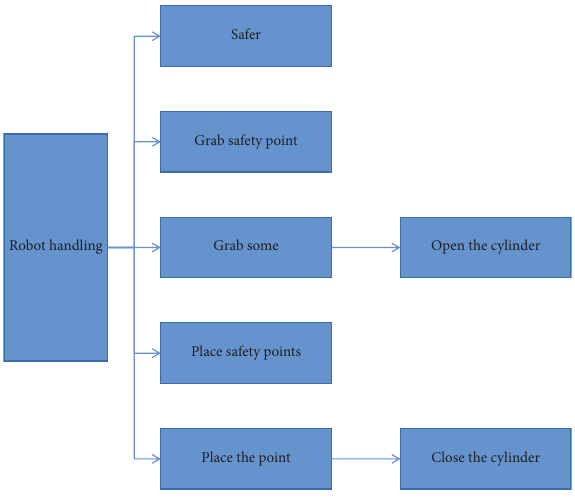
Figure 7: Trajectory